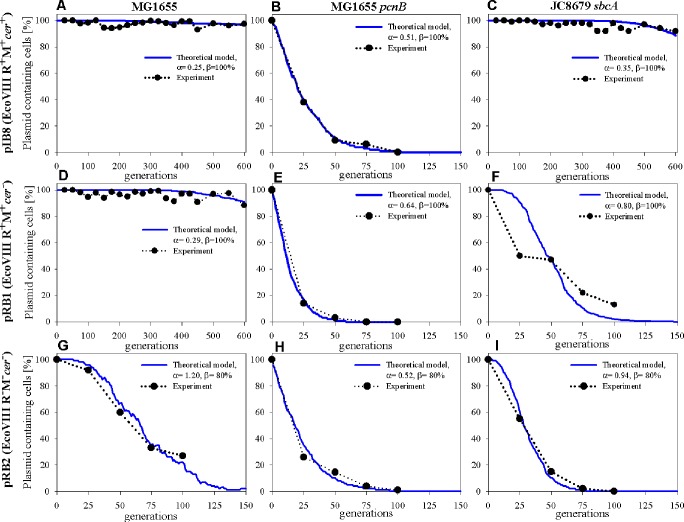
Comparison of experimental data obtained for pEC156-derivatives (pIB8, pRB1 and pRB2) maintenance in E. coli MG1655, MG1655 pcnB, and JC8679 sbcA with the theoretical model.Experimental points in panel B, E and H were taken from our previous report [35]. Continuous blue lines are best fit simulations for a given α parameter.